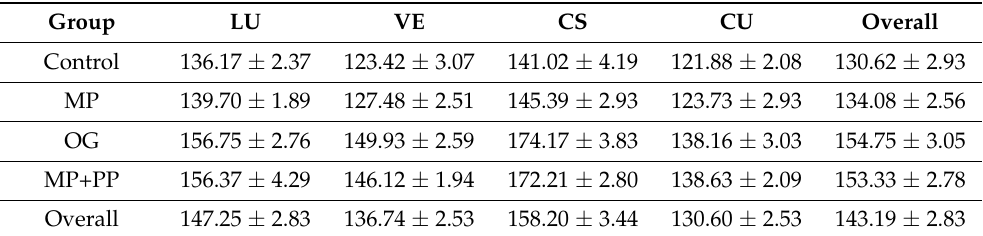
Table 7. Mean BFS (in MPa) of the material group after different surface finishing protocols.